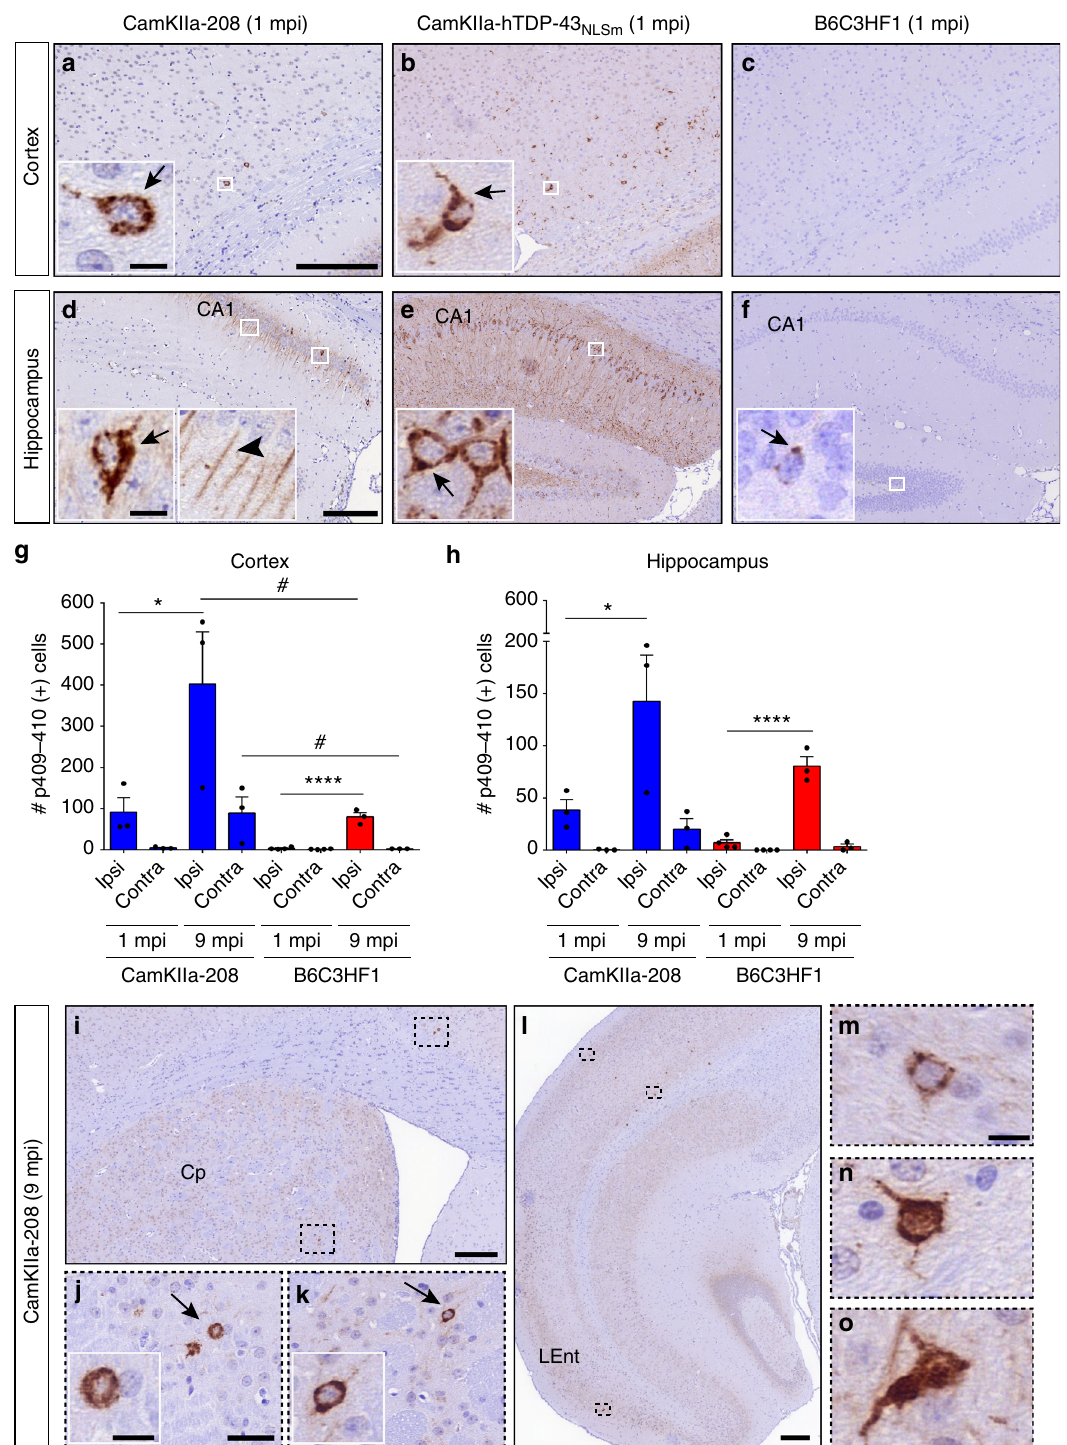
cortex or hippocampus of injected non-Tg mice at 1 mpi (Fig. 6c, f), with NCIs increasing over time by 9 mpi in the ipsilateral cortex and hippocampus. Quanti fi cation of pathol- ogy in injected non-Tg and CamKIIa-208 mice revealed a signi fi cant increase in the number of cells with pTDP-43 NCIs in the ipsilateral cortex and hippocampus with a trend toward an increase in the contralateral side in CamKIIa-208 mice (Fig. 6g, h). However, the dramatic increase in pTDP-43 NCIs in the cortex of CamKIIa-208 mice vs. non-Tg mice at 9 mpi